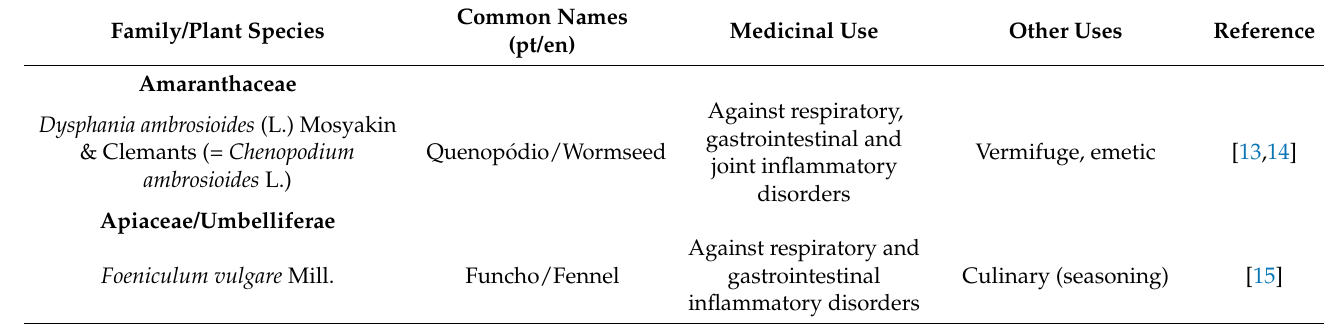
Table 1. Some of the traditional applications of the species studied in the present